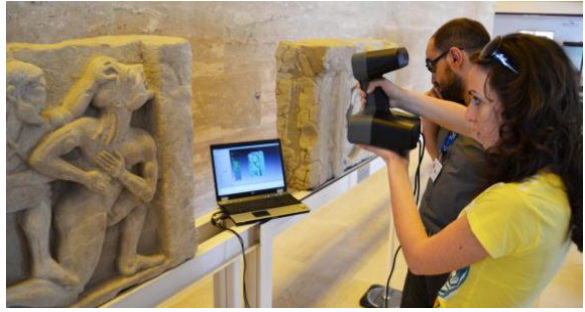
Figure 4. Data acquisition of the Metope with Artec MH/MHT